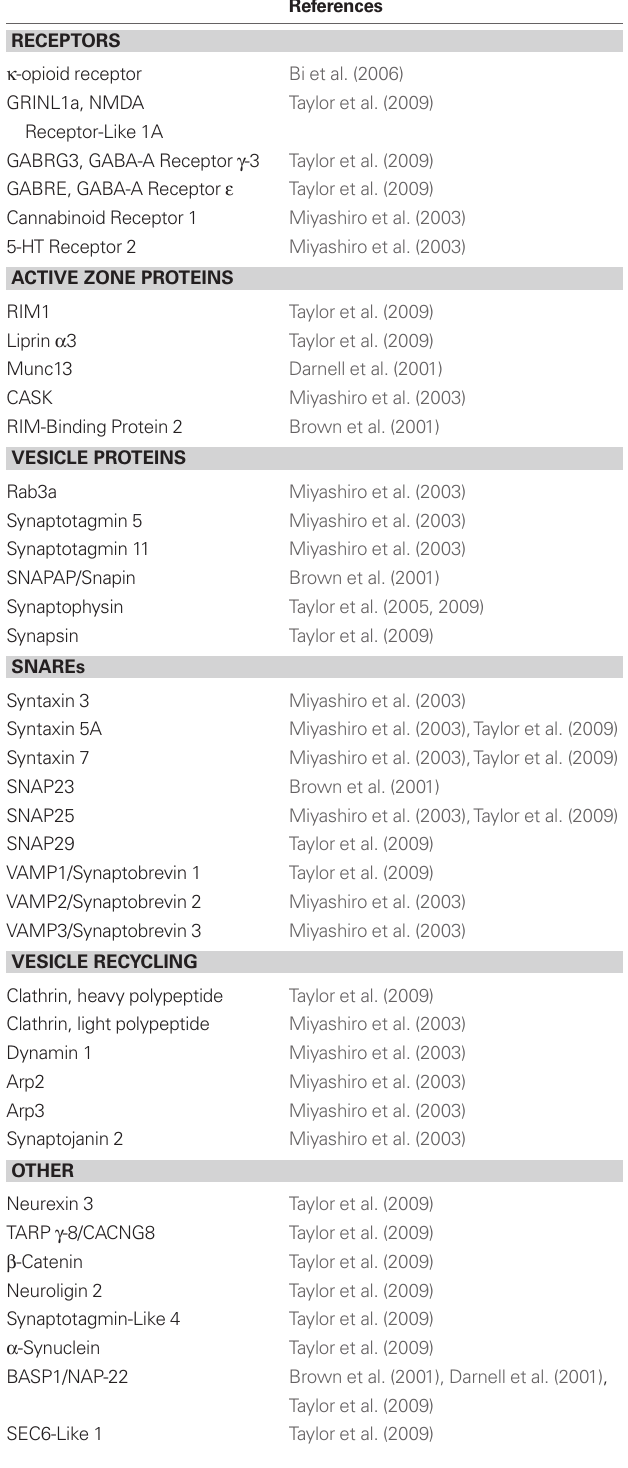
Table 1 | Candidate mRNAs for local presynaptic translation. The list comprises transcripts encoding proteins with a presynaptic function that meet one or more of the following criteria: Localization to axons (Taylor et al., 2005, 2009; Bi et al., 2006), binding to FMRP (Darnell et al., 2001; Miyashiro et al., 2003) , or FMRP-dependent ribosome association (Brown et al., 2001) . Standard names are given for messages originally identifi ed by their